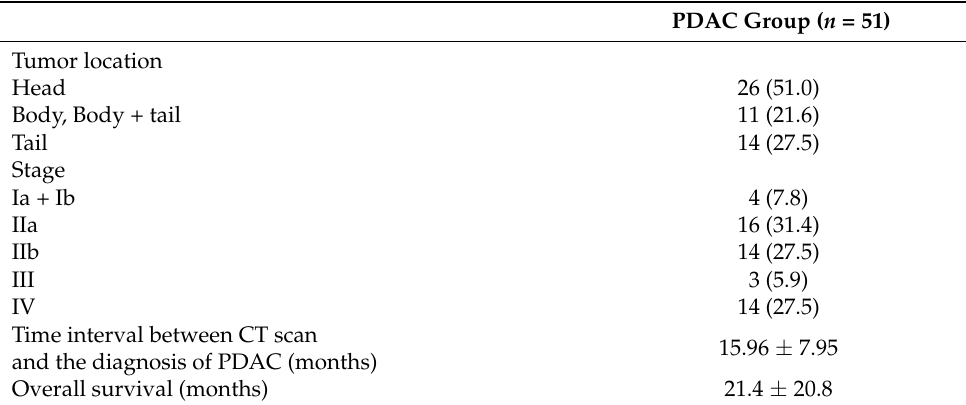
Table 2. Characteristics of PDAC group.